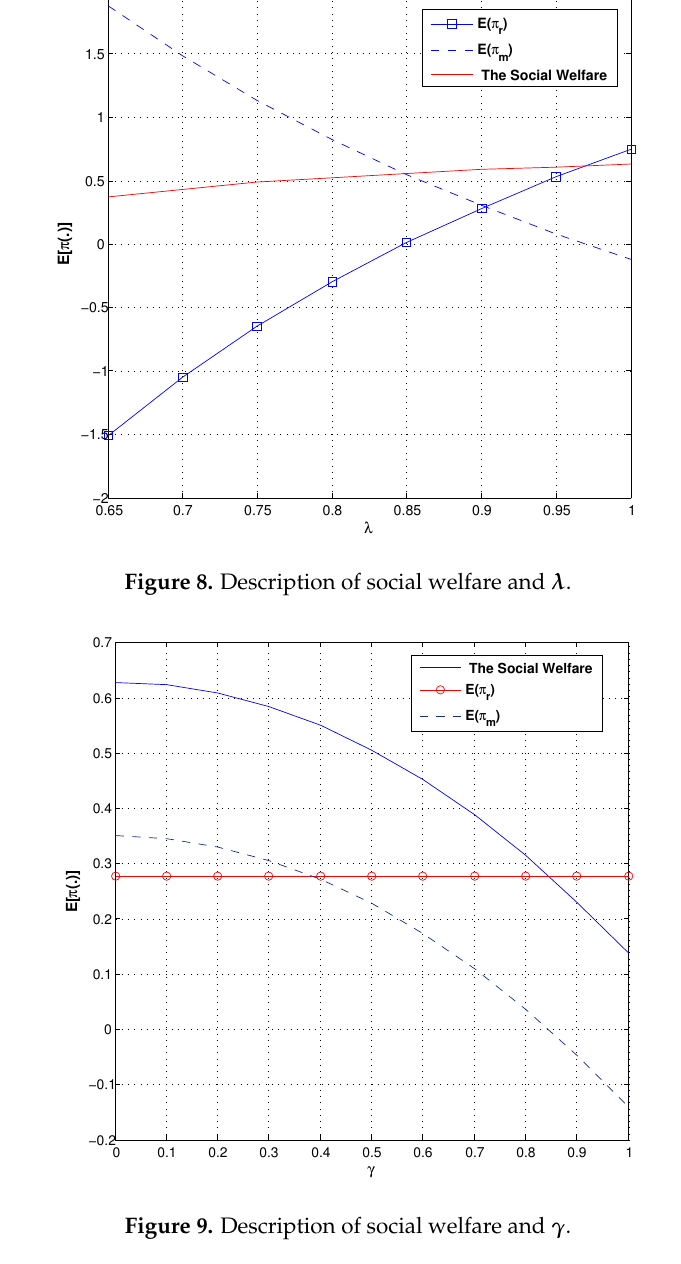
Figure 9. Description of social welfare and γ